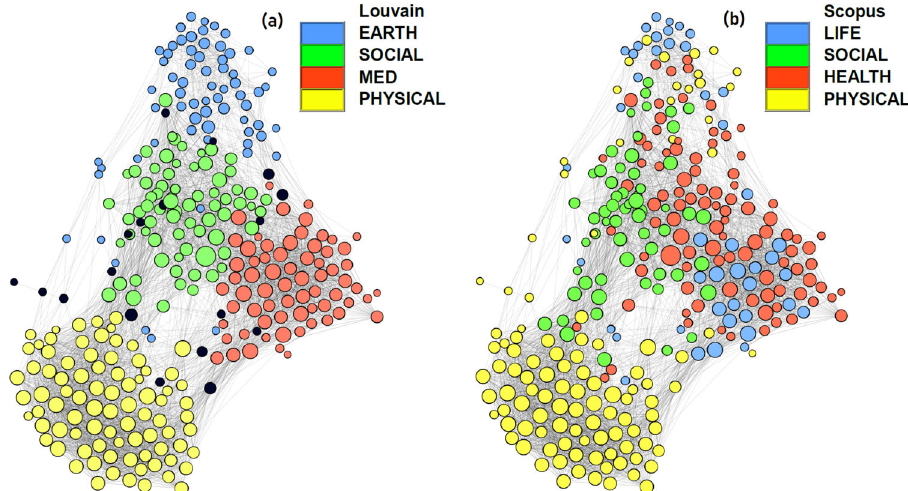
Fig. 9 Community structure of the network of co-occurrence between scienti fi c fi elds, validated by the Hypergeometric null model. The link density is ρ = 0.2, corresponding to the maximum adjusted mutual information (AMI) value of Fig. 8. a Each color identi fi es a community (hand-labeled by us as in the legend) shared among the four validated networks, whereas the few black nodes denote the mismatches. The network is represented using a force atlas layout. b As a comparison, we report the same network with scienti fi c fi elds labeled according to their ASJC (All Science Journal Classi fi cation) subject area assigned by Scopus' in-house experts. Visually, the community structure de fi ned by such classi fi cation is not much coherent with the network partition induced by our meta-validation approach based on signi fi cant co-occurrences, which we recall links two scienti fi c fi elds when they require common